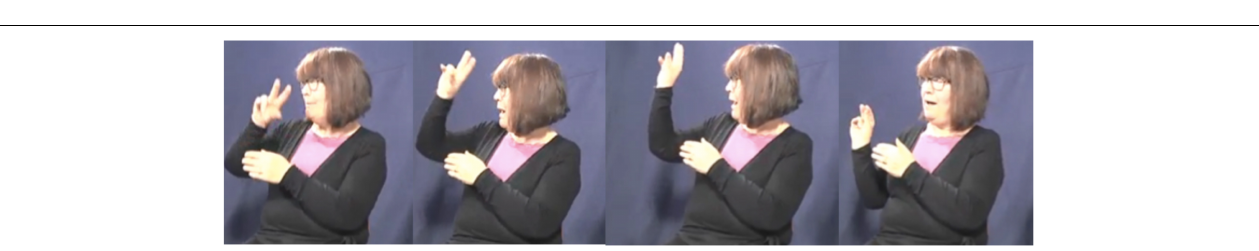
FIGURE 7 | The modified fully-lexical sign FLS: tree-falls-down, as produced in example 1. Figure reproduced with permission from Corpus VGT (Van Herreweghe et al., 2015).